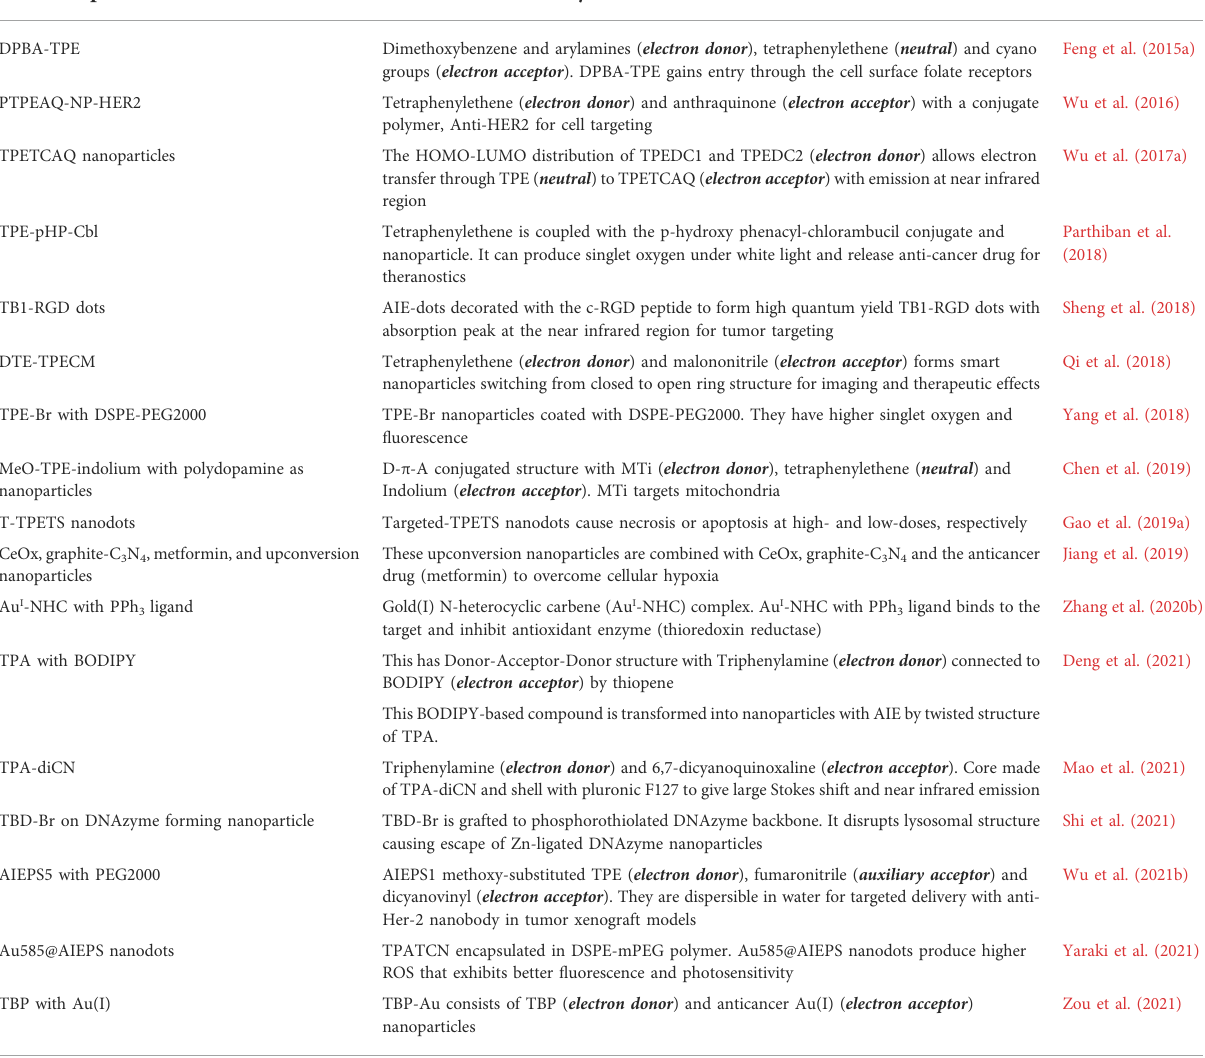
TABLE 3 AIE-photosensitizer nanoparticles for anti-cancer